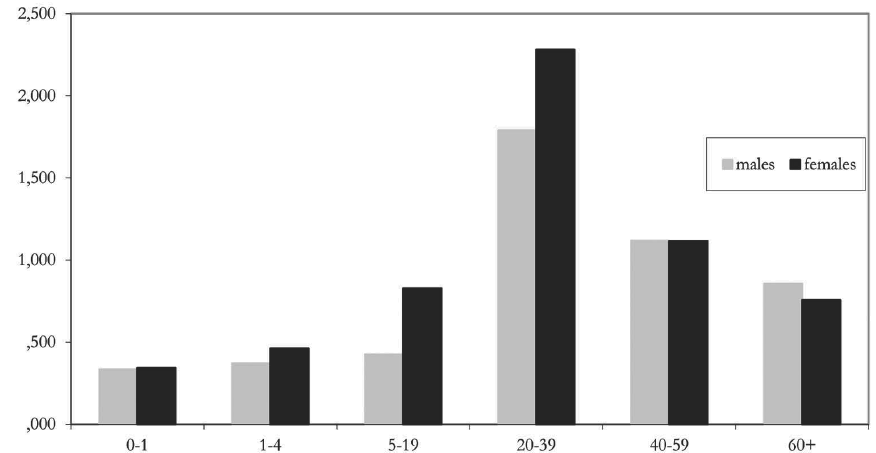
Figure 8 – Age and sex specific death rates for pulmonary tuberculosis in Italy (1888).